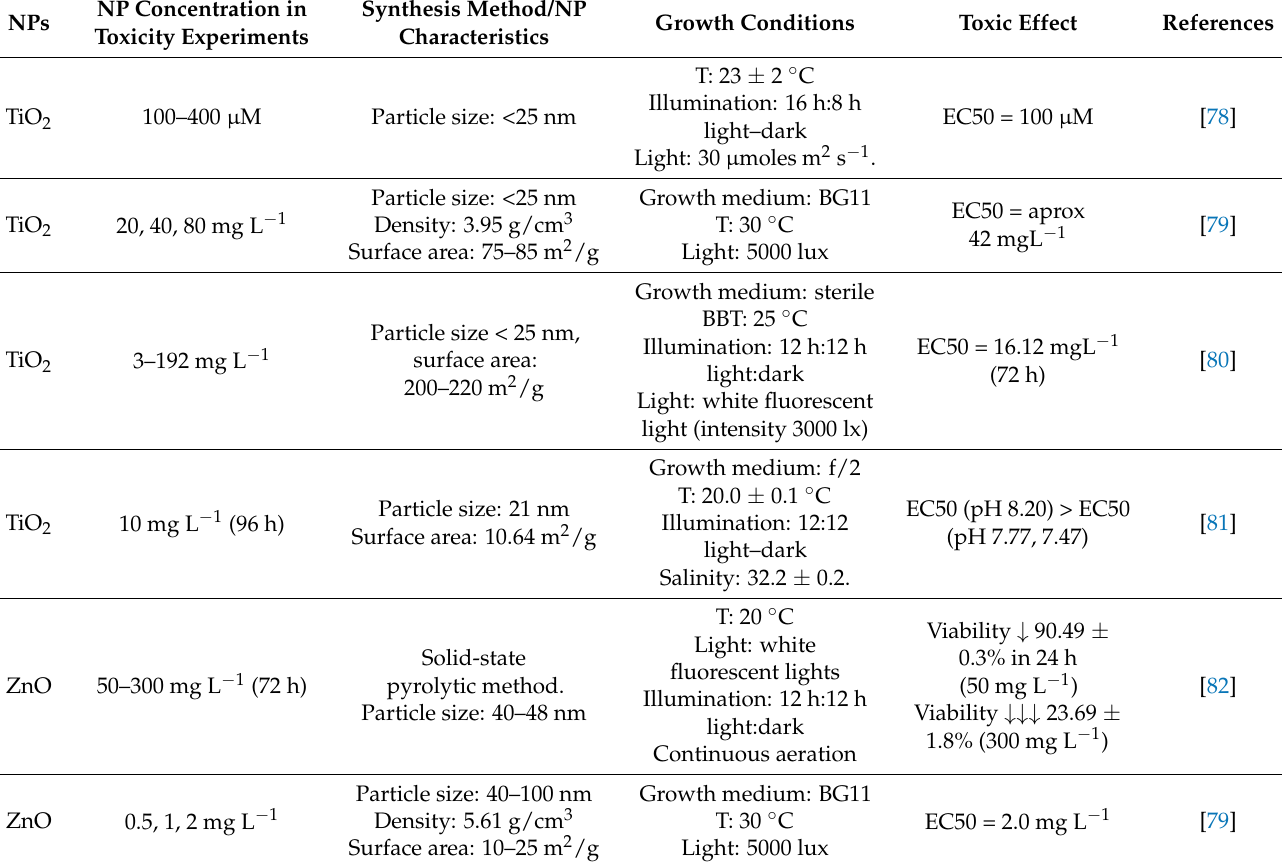
Table 3. Toxic effect of nanoparticles (NPs) to Chlorella vulgaris